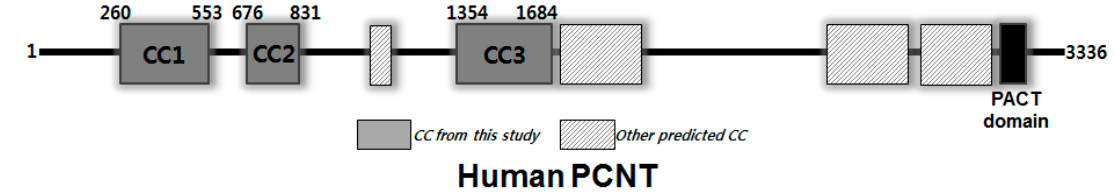
Figure 1. Regions of human pericentrin (PCNT) showing predicted coiled-coil (CC) and the PACT domain.